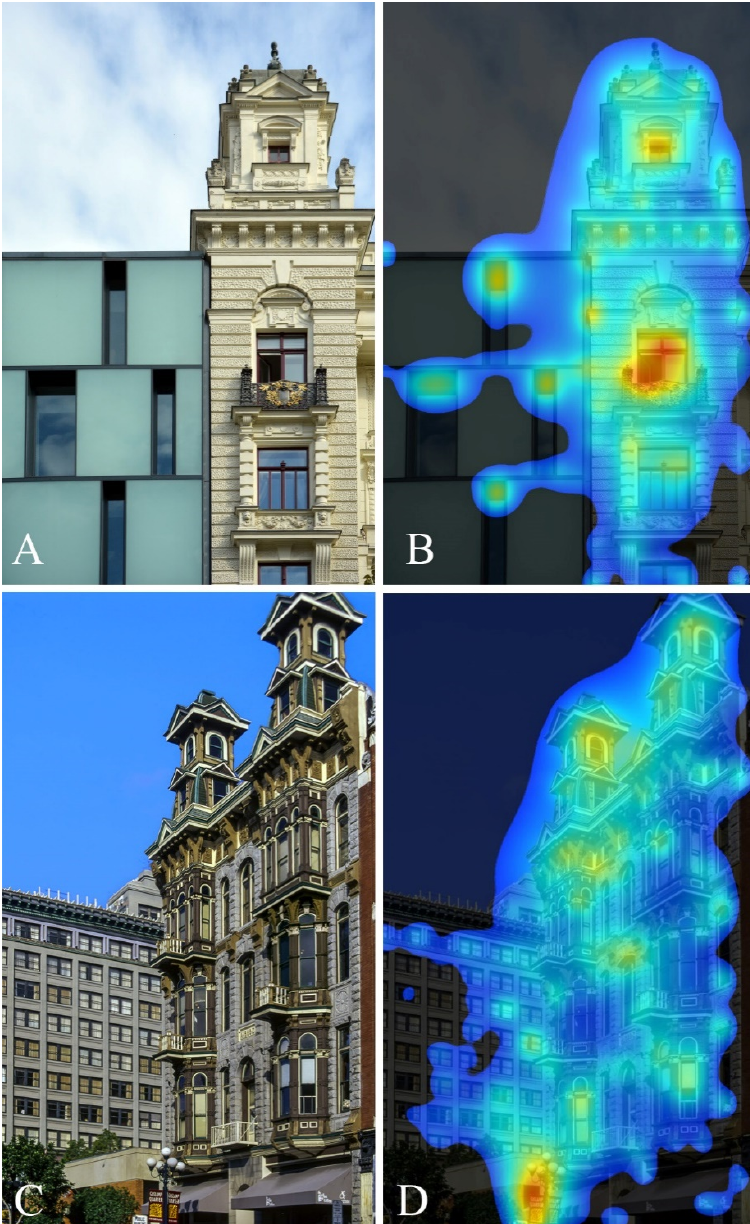
Figure 4. The Omega Palace department store building from the 2000s (left) and the House of Four Giants from the 1900s (right), in Freedom Square in Brno, Czech Republic ( A , B ); and the 1880s Louis Bank of Commerce building on 5th Avenue, San Diego, California with a modern building with symmetric distribution of openings in the background ( C , D ).